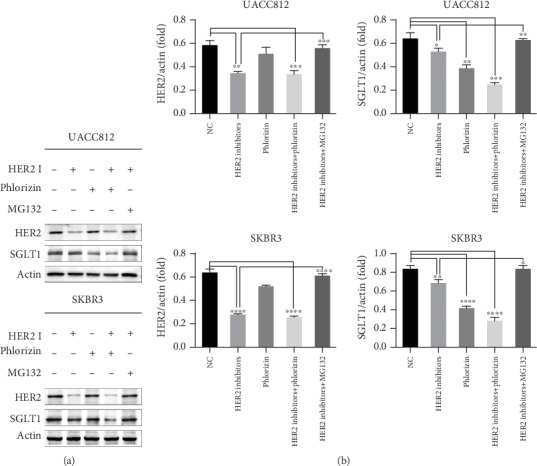
Representative western blot of HER2 and SGLT1 expression levels and quantification relative to actin in UACC812 and SKBR3 cells. UACC812 and SKBR3 cells were treated with HER2 inhibitors (HER2 I), Phlorizin, MG132 alone, or in combination for 48 h. Untreated cells were used as a negative control (NC). (a) A representative WB detection result of three independent experiments was shown. (b) The relative levels of HER2 and SGLT1 protein in UACC812 and SKBR3 cells. Statistically significant differences between groups were displayed; ∗∗∗∗p < 0.0001; ∗∗∗p < 0.001; ∗∗p < 0.01; ∗p < 0.05.